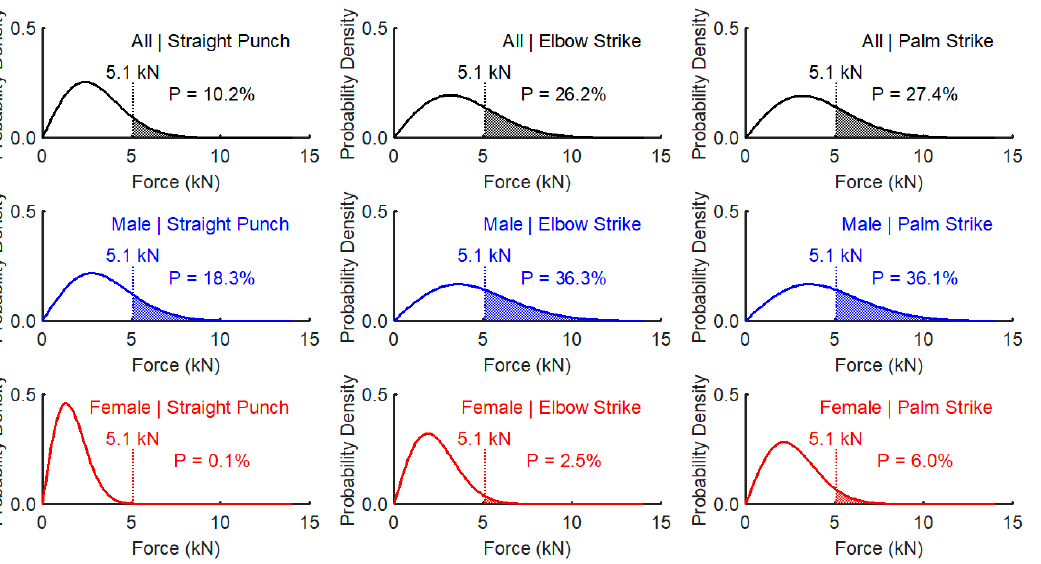
Figure 5. Probability of exceeding the 5.1 kN threshold force. The blue color – Male, the red color - Female.